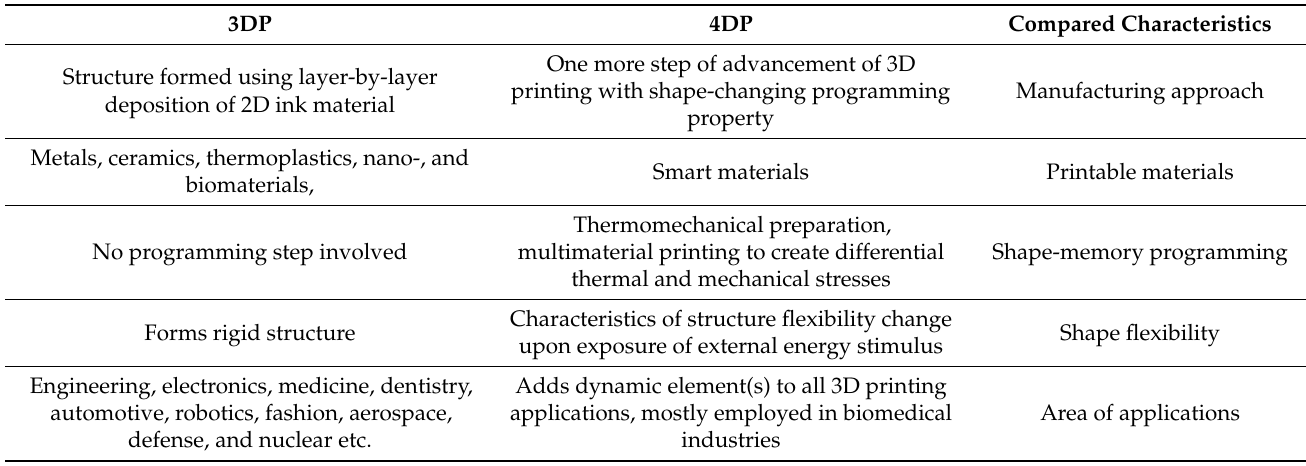
Table 1. Characteristic distinctions between 3D and 4D printing